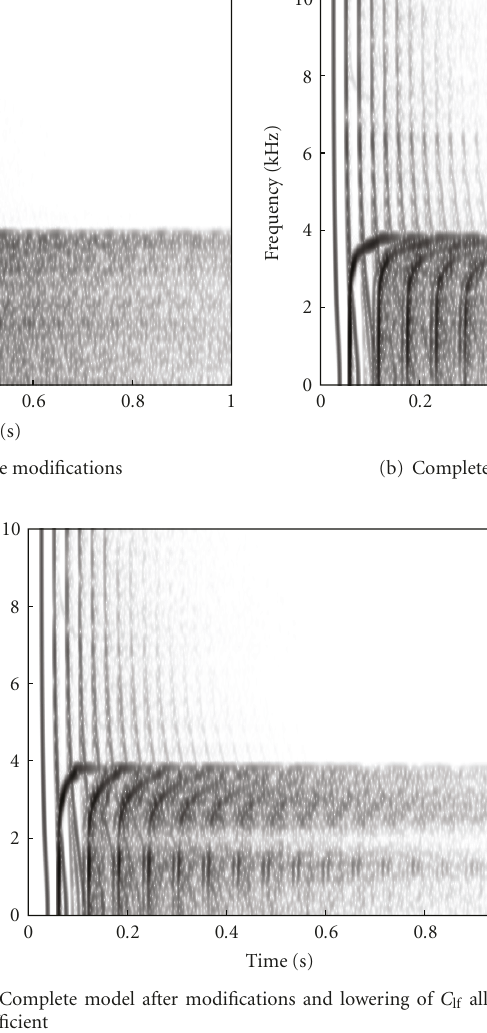
Figure 9: Spectrograms of the impulse response of the complete spring reverberation e ff ect, before and after the e ffi ciency modifications are